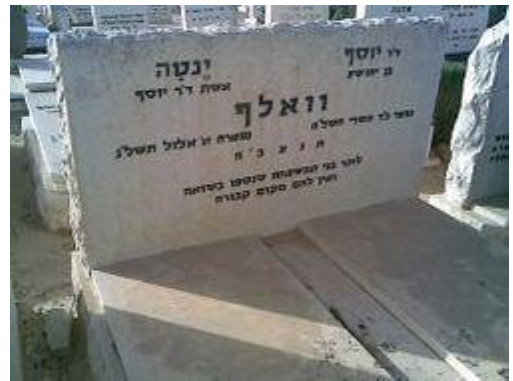
Figure 3. Grave of Joseph